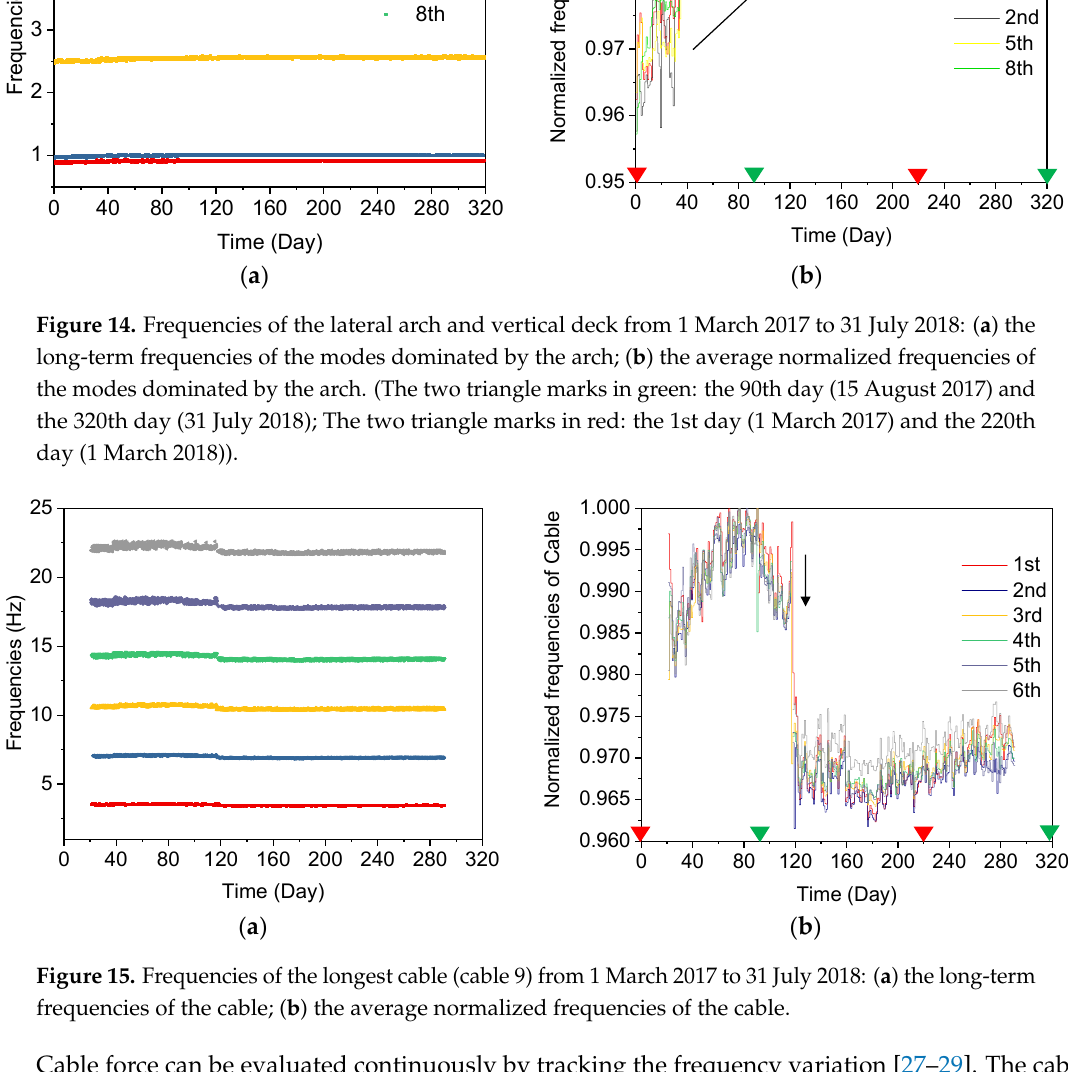
Figure 15. Frequencies of the longest cable (cable 9) from 1 March 2017 to 31 July 2018: ( a ) the long- term frequencies of the cable; ( b ) the average normalized frequencies of the cable.